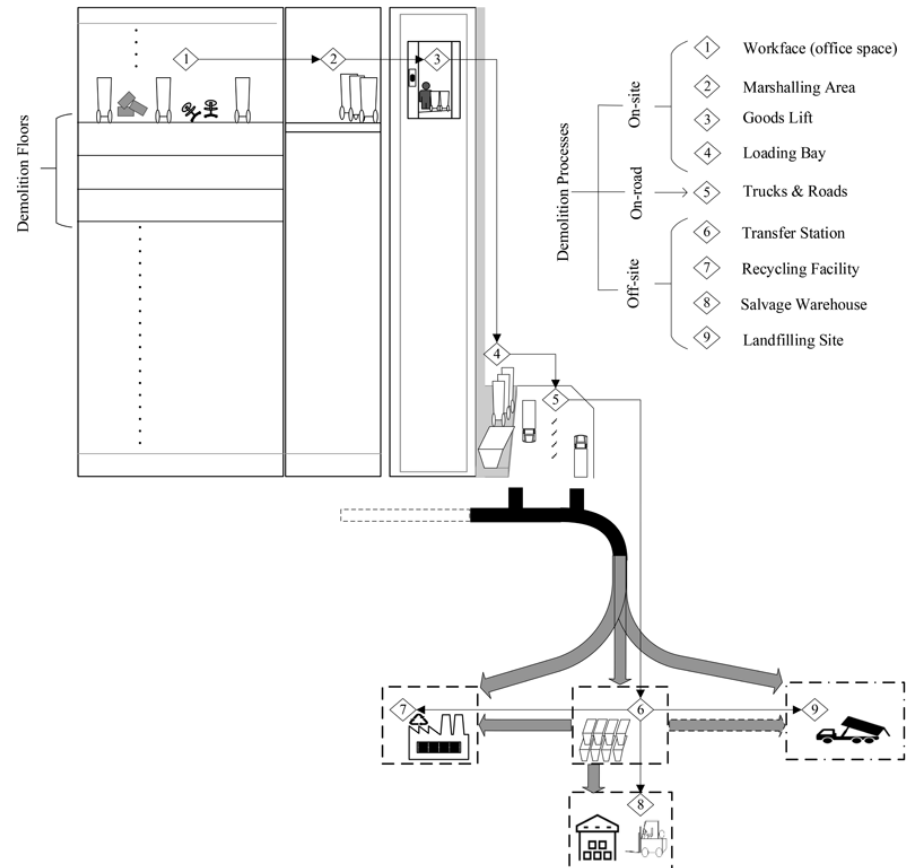
Figure 2 Fit-out Waste Stream Map in A-Grade Office Buildings